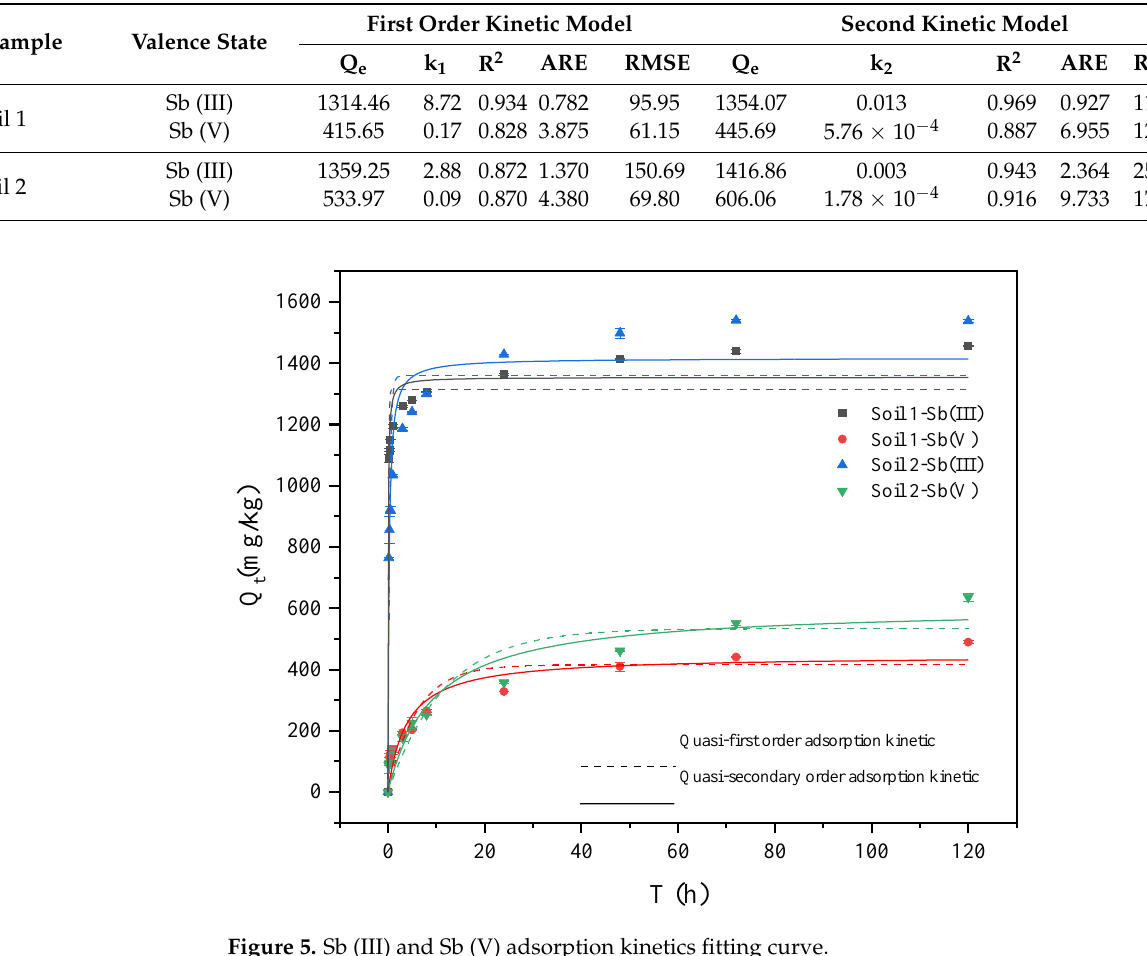
Figure 5. Sb (III) and Sb (V) adsorption kinetics fitting curve. Table 2. Sb (III) and Sb (V) adsorption kinetic model parameters.